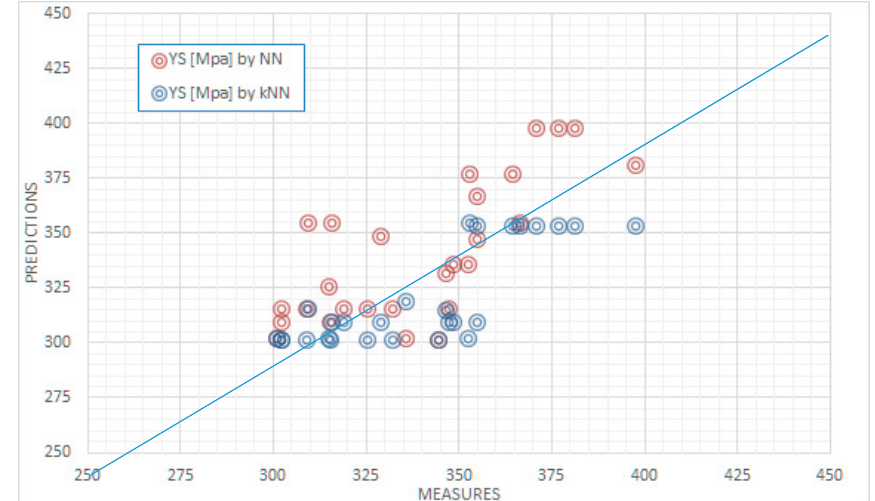
Figure 5. A graphical representation of data with equal Pearson correlation coefficients. It is the case of YS (MPa) for SGI with coefficients of, respectively, 0.74 (NN) and 0.79 (kNN).